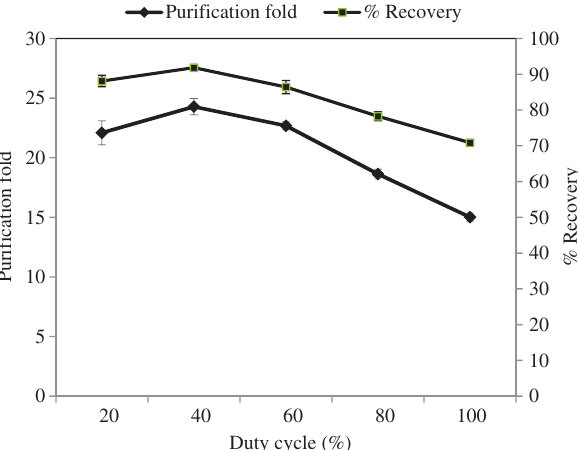
Figure 7: Effect of duty cycle on ultrasound assisted three phase partitioning (UATPP) of